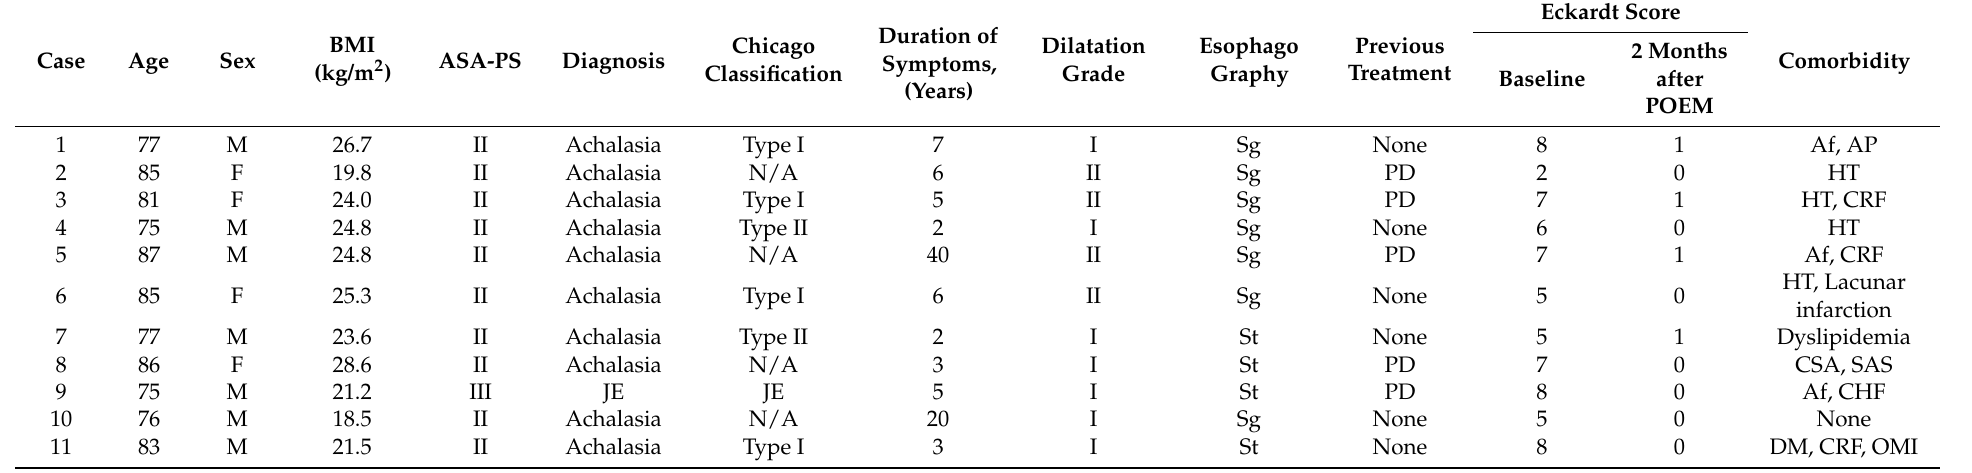
Table 1. Patient